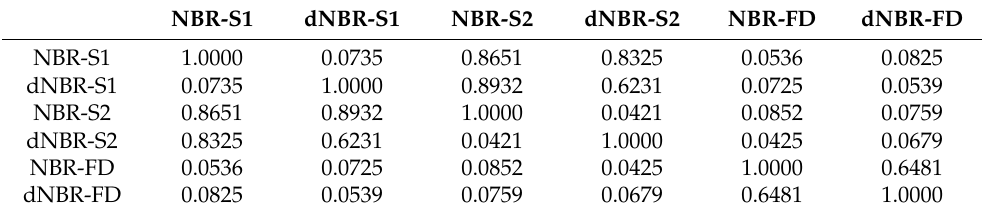
Table 5. Pearson’s correlation coefficient between satellite derived and ground based derived